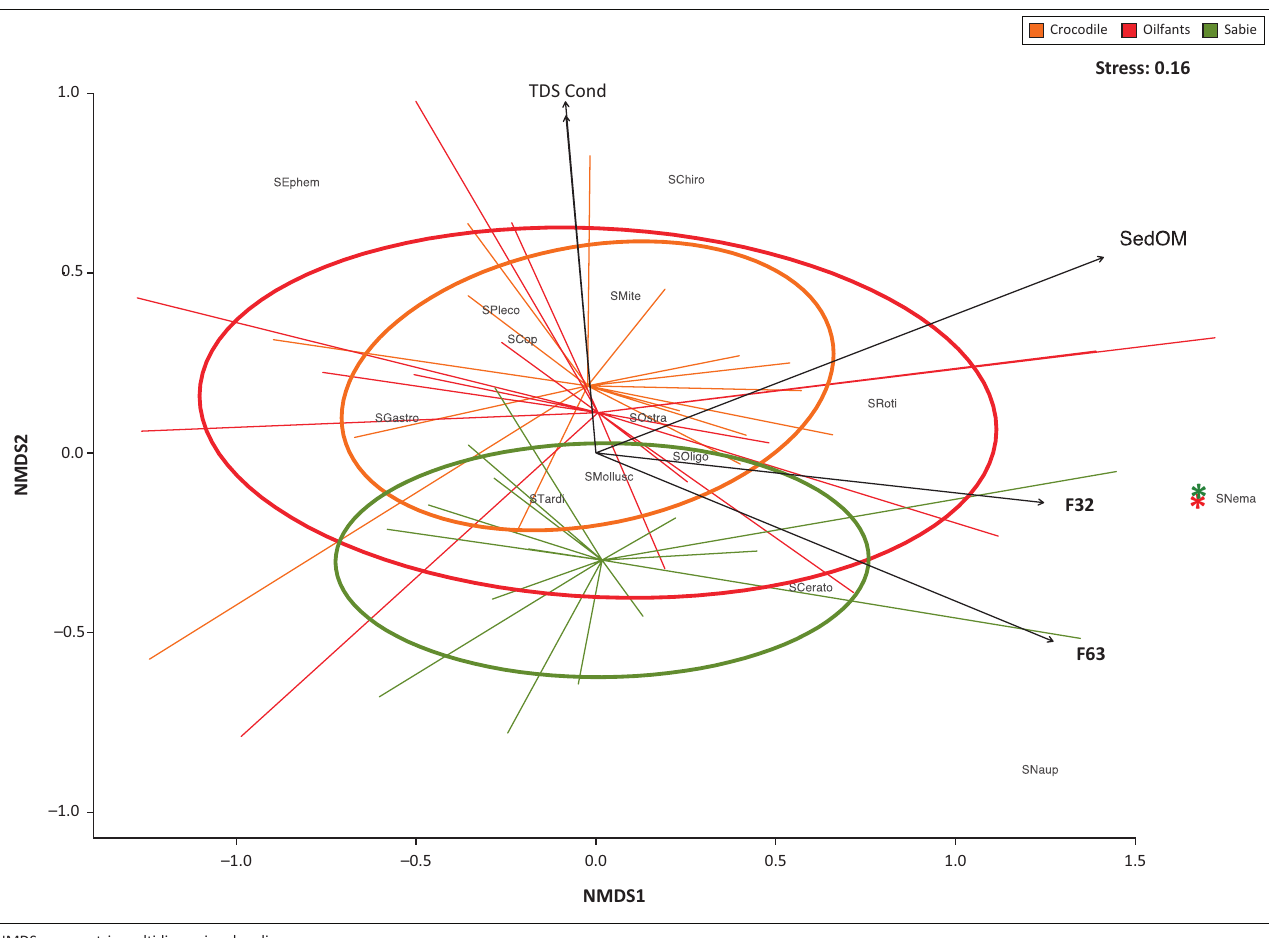
FIGURE 4: Non-metric multidimensional scaling ordination sediment-dwelling meiobenthic community. Ordination is based on untransformed absolute abundances (ind. gSedDM –1 ).